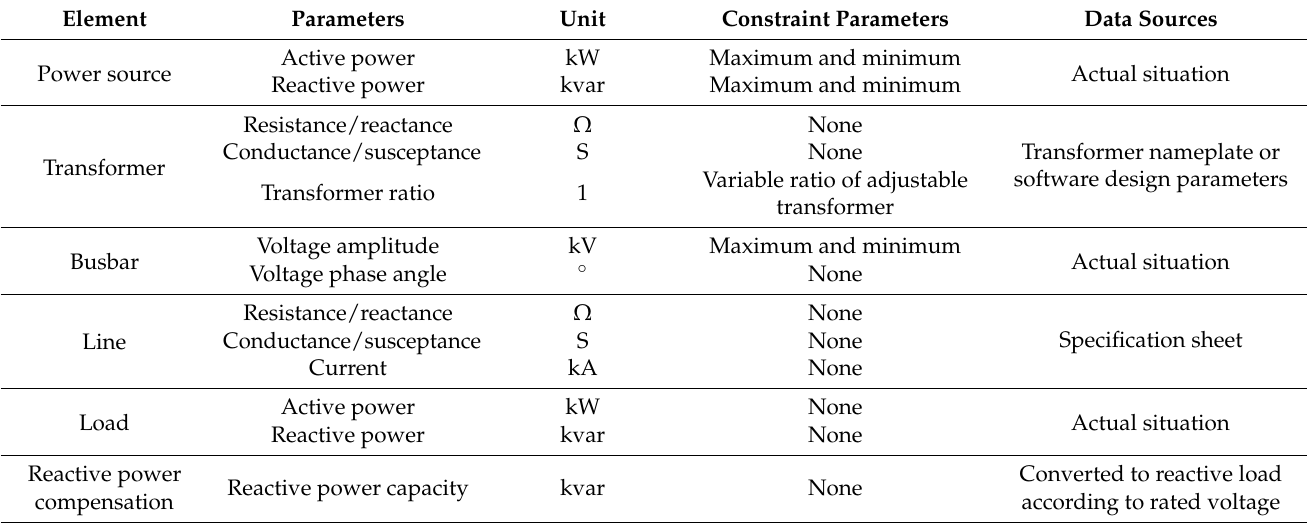
Table 10. Parameters for power flow